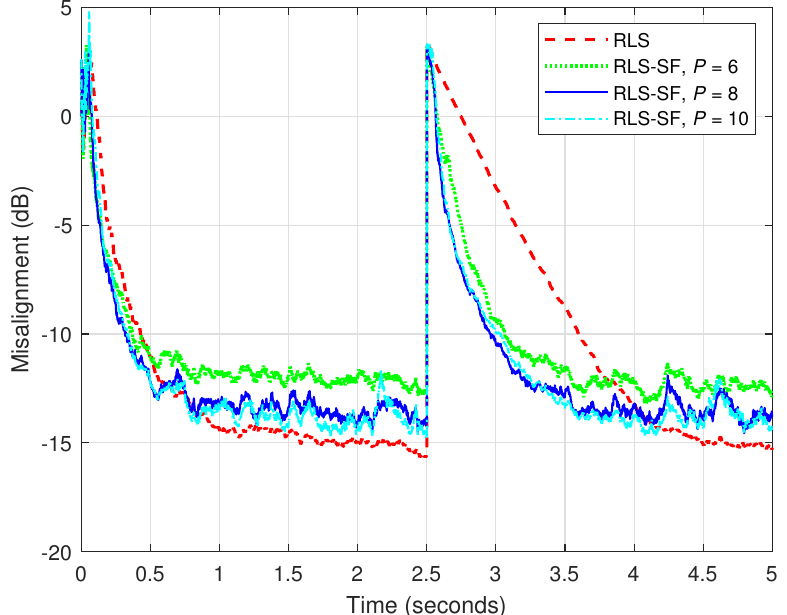
Figure 13. Performance of the conventional RLS filter [with λ = 1 − 1/ ( KL ) ] and the RLS-SF [with λ 1 = 1 − 1/ ( KPL 1 ) and λ 2 = 1 − 1/ ( KPL 2 ) ], using K = 10, for the identification of the acoustic echo paths from Figure 1c,d. The input signal is an AR(1) process, SNR = 10 dB, and the echo path changes after 2.5 s.